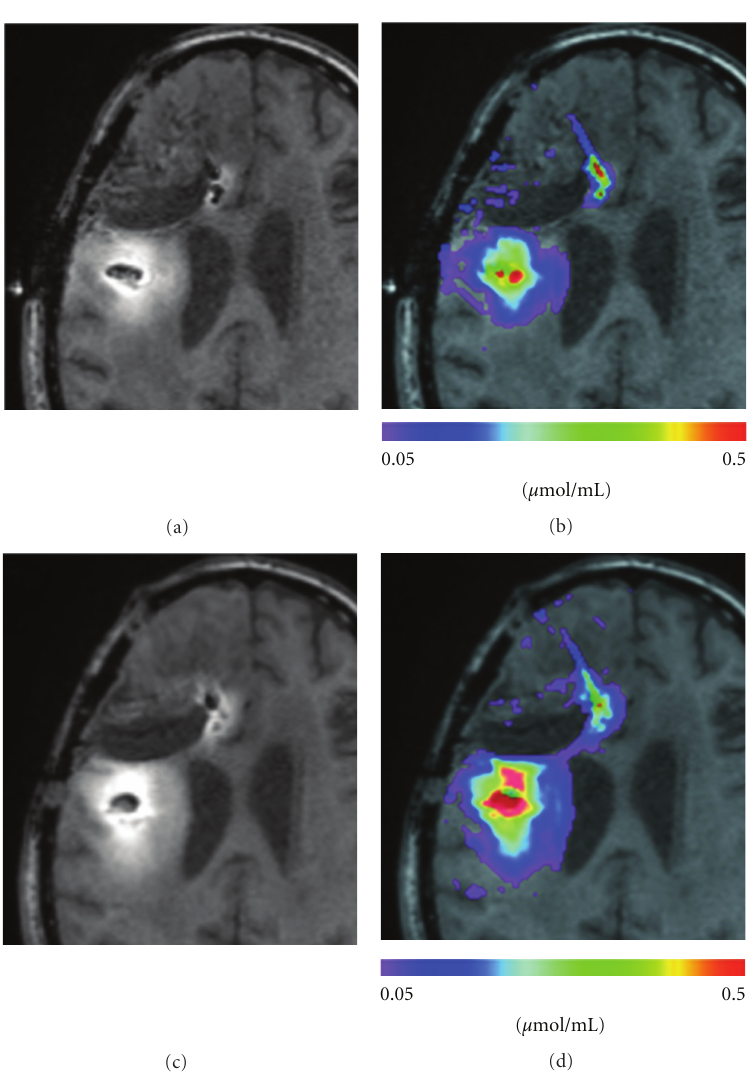
Figure 1: T1-weighted signal of MR1-1-PE38KDEL (a and c), compared with measured concentration profile of Gd-DTPA (b and d). (a) T1- weighted signal of MR1-1-PE38KDEL at 24 hours. (b) Concentration of Gd-DTPA at 24 hours. (c) T1-weighted signal of MR1-1-PE38KDEL at 72 hours. (d) Concentration of Gd-DTPA at 72 hours. Gd-DTPA, gadolinium-diethylene triamine pentaacetic acid. Reprinted from [122] with permission from Wolters Kluwer Health (license number